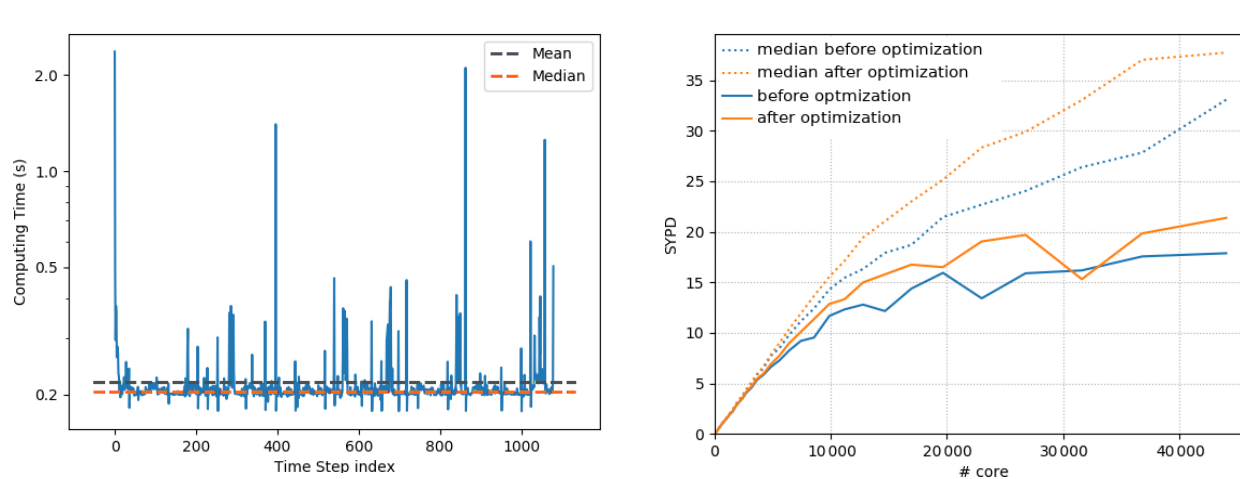
Figure 10. Strong scaling performance: simulated years per day (SYPD) as a function of the number of cores used in the simula-